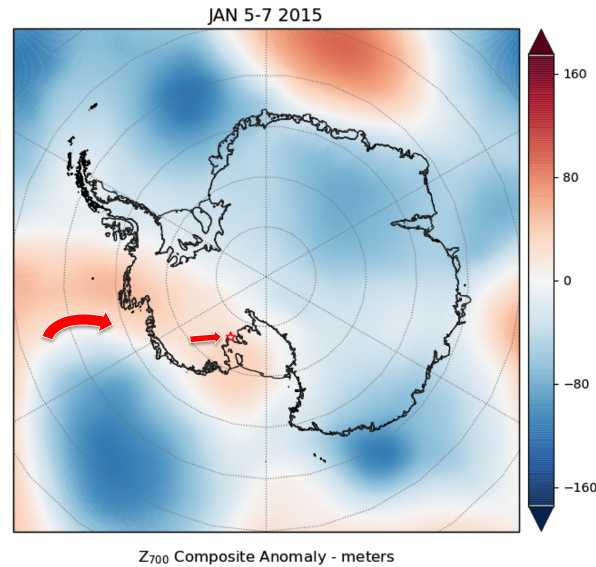
Figure 2. Composite anomaly of ERA5 700hPa geopotential height for 5–7 January 2015. The red star depicts the location of Siple Dome. The red arrows depict the direction of 700hPa winds rel- evant to the case